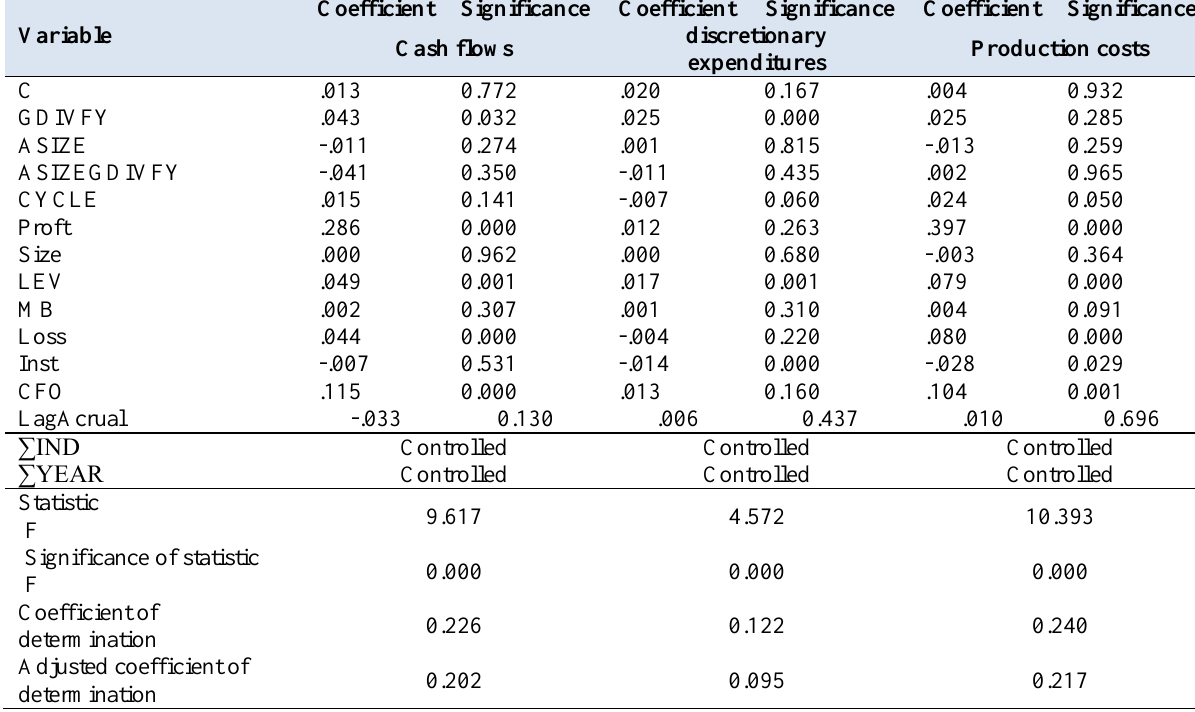
Table 7. The Results of Testing the Fourth Research Hypothesis (Dependent Variable: Real Earnings Management, Independent Variable: Auditor